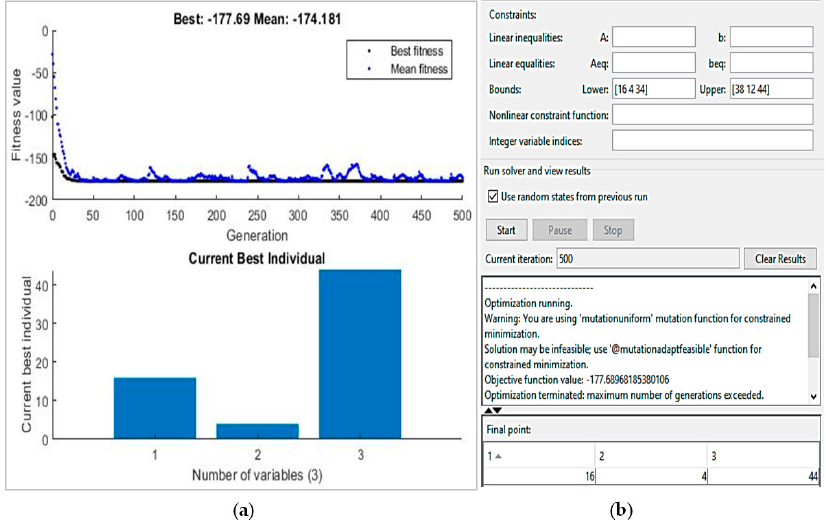
Figure 4. The results of GA optimization: ( a ) convergence of fitness values, ( b ) converged values of welding parameters.